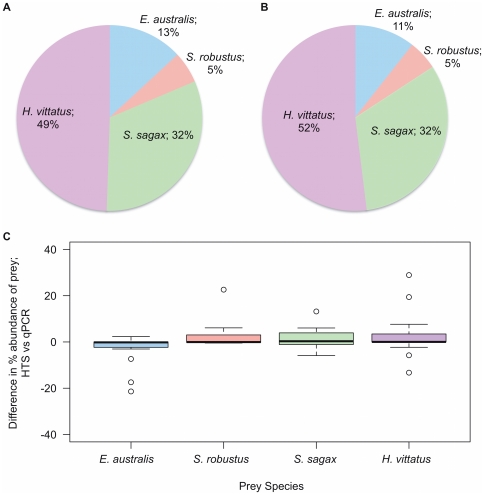
Comparison of HTS and qPCR methods determining the proportion of four major fish species.Graphs indicate the relative percentage composition of H. vittatus, S. sagax, E. australis and S. robustus within faecal samples of E. minor on Penguin Island, as determined by (A) qPCR and (B) HTS of samples collected during the period of Oct ‘10-Dec ’10. (C) Box plot showing the difference between the results obtained by HTS and qPCR for each of the four major fish species found in the diet of E. minor. Samples whose CT values were >34 have been excluded from the dataset (see Materials and Methods).